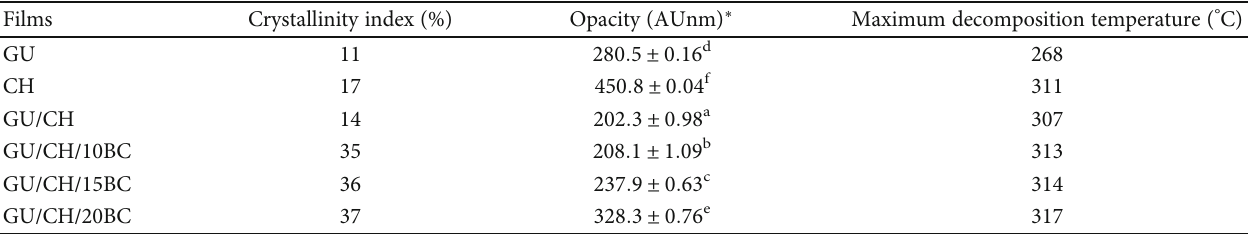
Figure 3: The XRD patterns of all samples. Table 2: Crystallinity index, opacity value, and thermal properties of all samples.